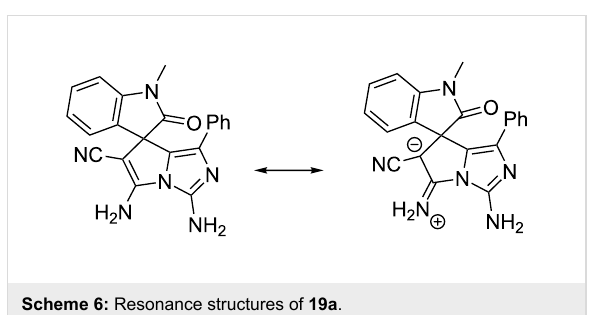
Scheme 6: Resonance structures of 19a